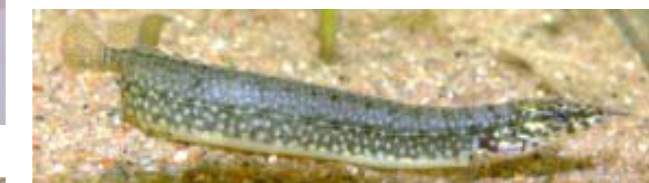
Image 22. Barred Spiny Eel Macrognathus pancalus